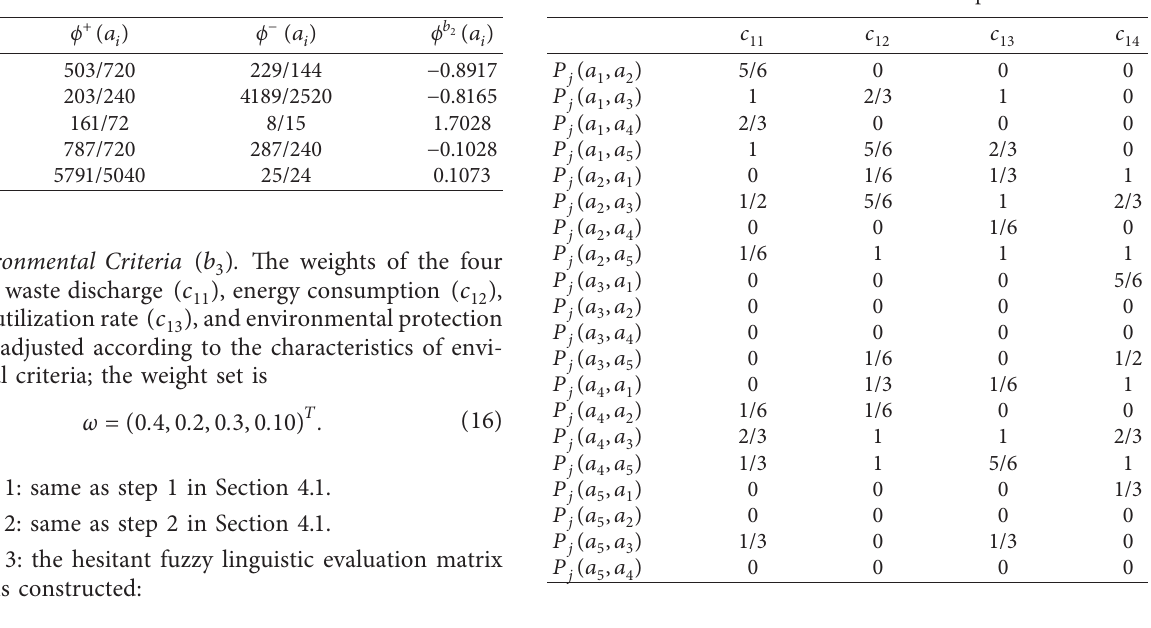
Table 7: The net flow of social criteria. Table 8: Environmental criteria dispersion.